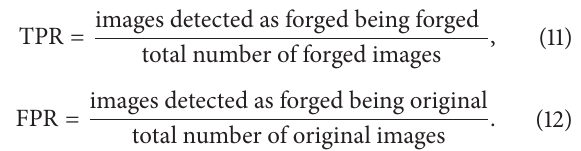
show that SURF feature descriptors are invariant towards different combination of scaling and rotation. In the presence of JPEG compression, Gaussian noise addition and gamma correction attack; this method gives good result. HAC is used here for creating the regions from matched keypoints.